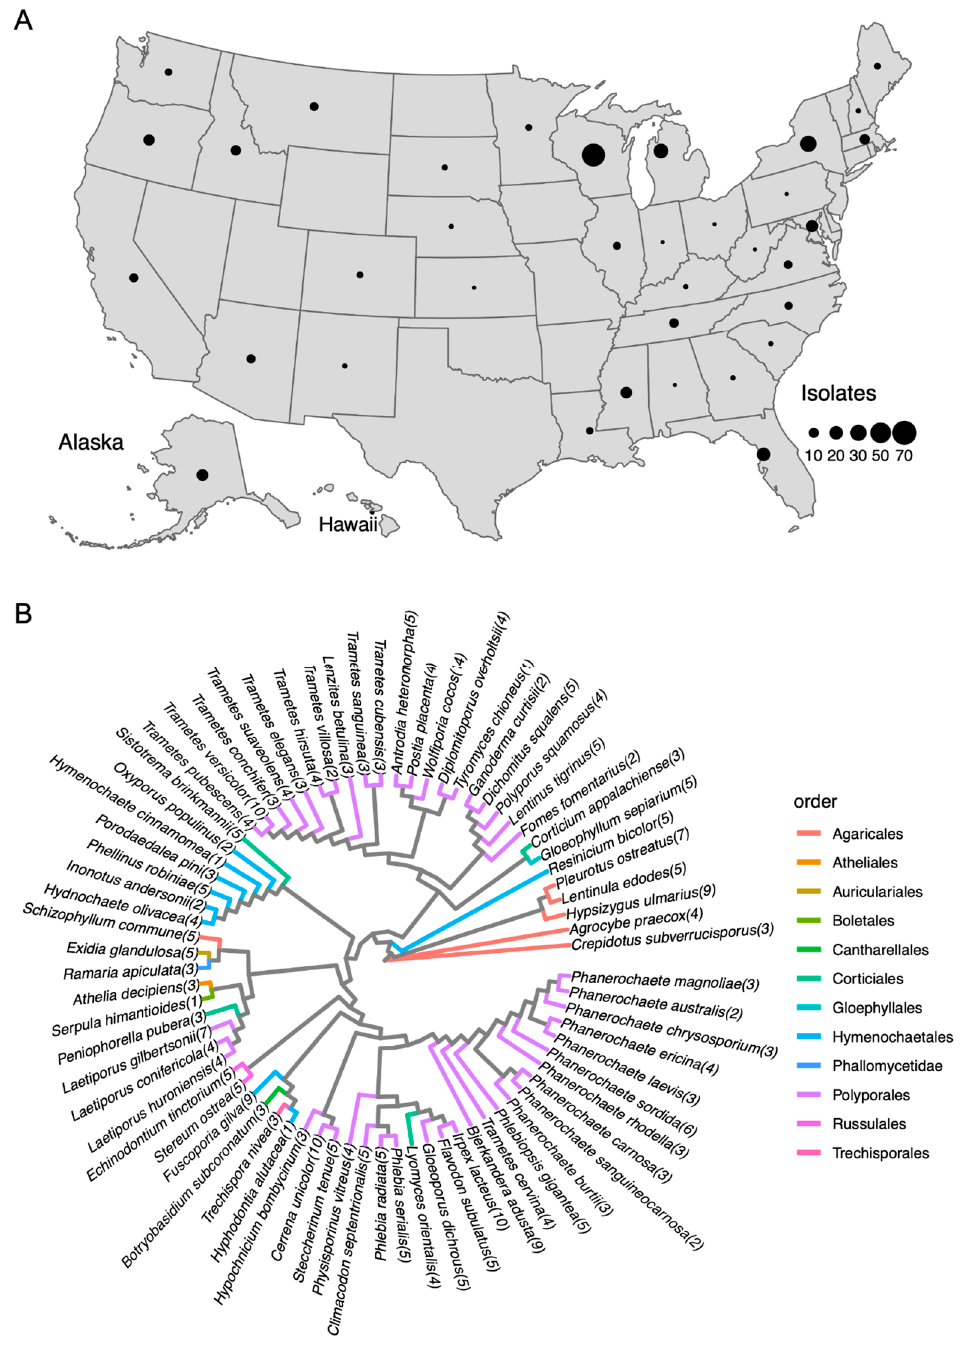
Figure 2. Geographic map and phylogenetic map of the fungal isolate collection. ( A ) 314 out of 320 isolates were collected in the United States across 38 states, including the Virgin Islands, Hawaii, and Alaska. Three isolates from Ontario, Canada, and one from China, are shown on the map. The collection regions of the two isolates were unknown. The sizes of the circles represent the number of isolates collected from the corresponding states. ( B ) Phylogenetic tree of ITS region from the fungal species in this study. The numbers in parentheses following species names indicate the number of isolates in the species. Branches are highlighted with colors corresponding to the order level of classification of each species.